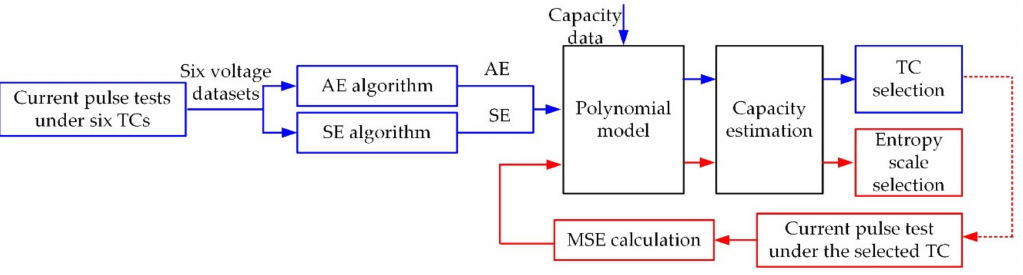
Figure 9. The overview of the proposed analysis method.